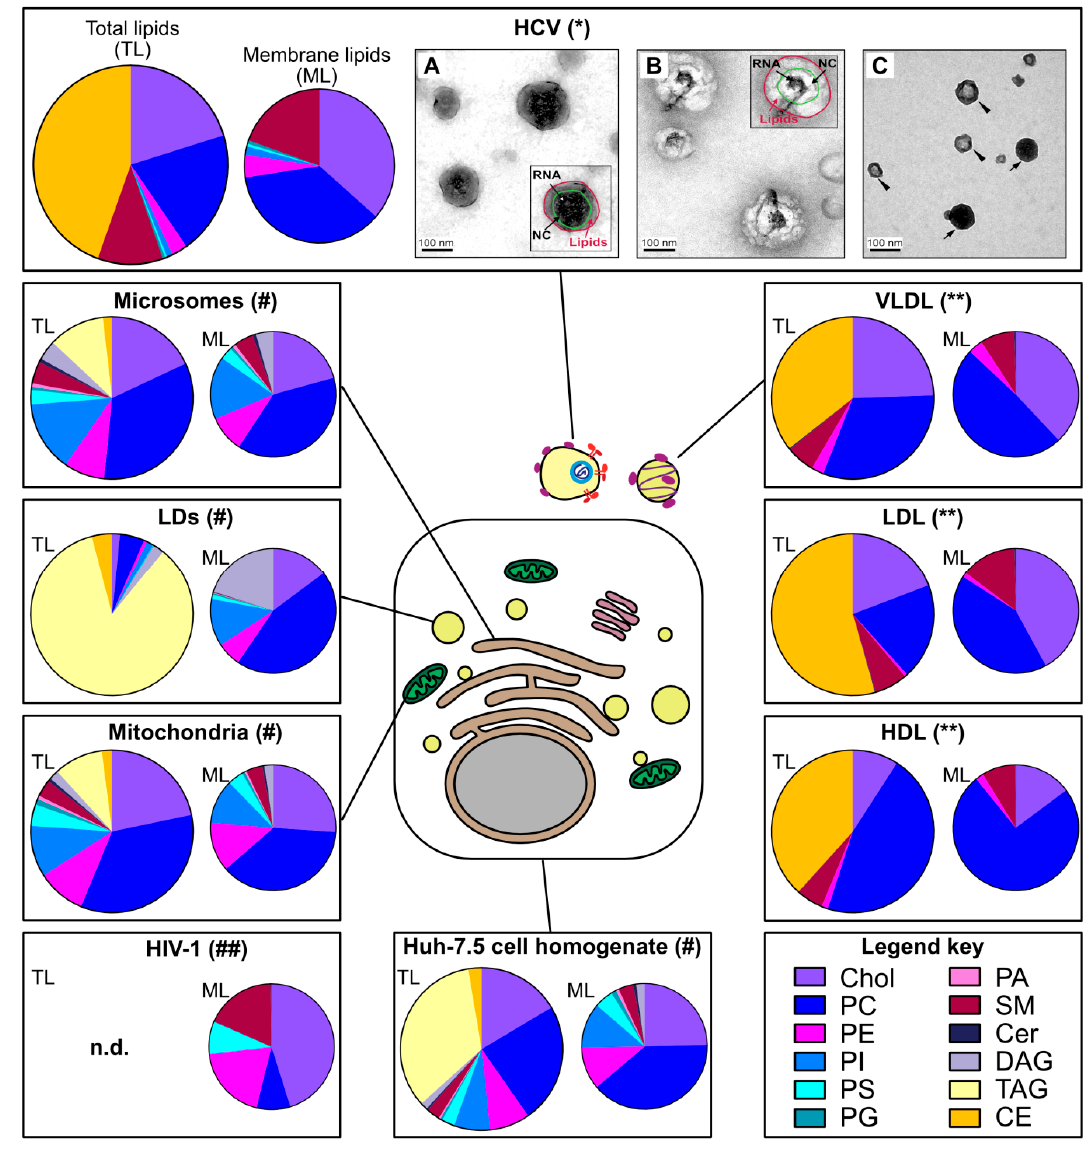
Figure 1. Hepatitis C virus (HCV) atypical lipid profile and morphology mimic serum